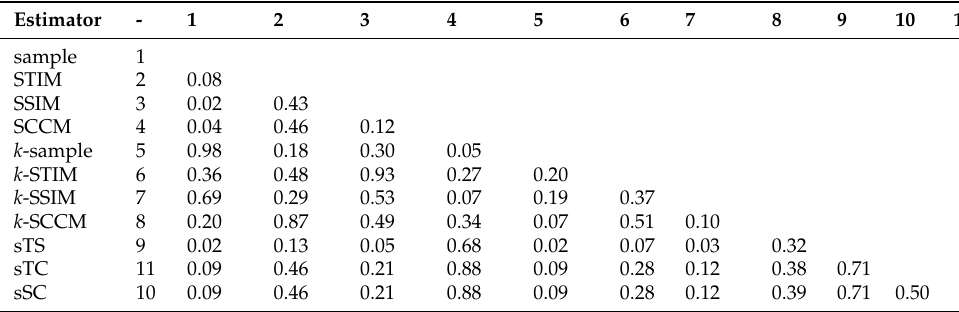
Table A5. p -Value of the Sharpe ratio for each pair of covariance estimators in Table 3.